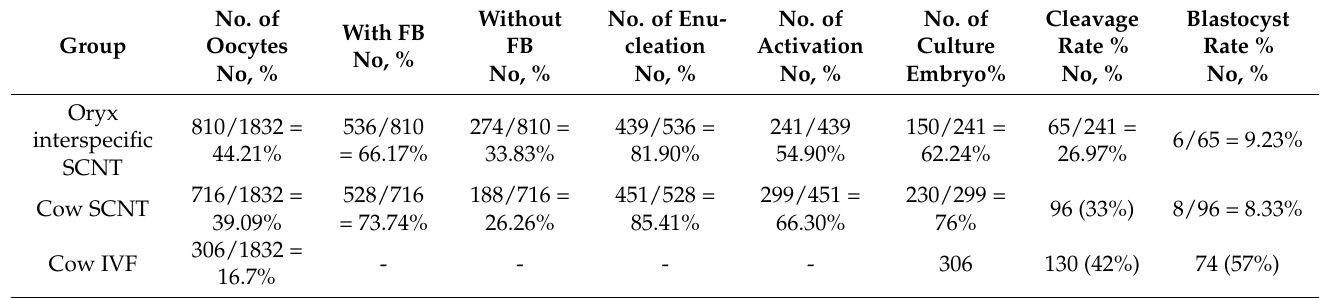
Table 1. The number of cow oocytes used for cloning Oryx and cow-cleaved embryos of interspecific Table 2. The comparison of the cloned Oryx interspecific somatic cell nuclear transfer, Cow SCNT, somatic cell nuclear transfer, (SCNT) and in vitro fertilization (IVF). and IVF of cow embryo developmental stages.